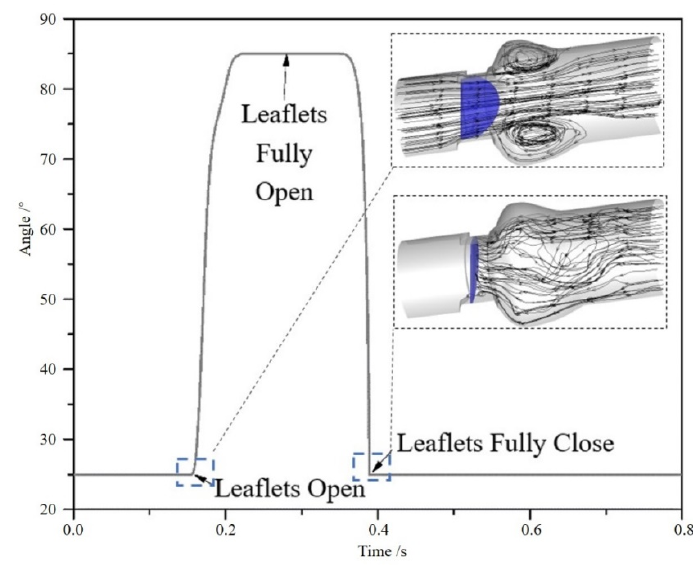
Figure 4. The motion of the leaflets in a cycle and streamlines.